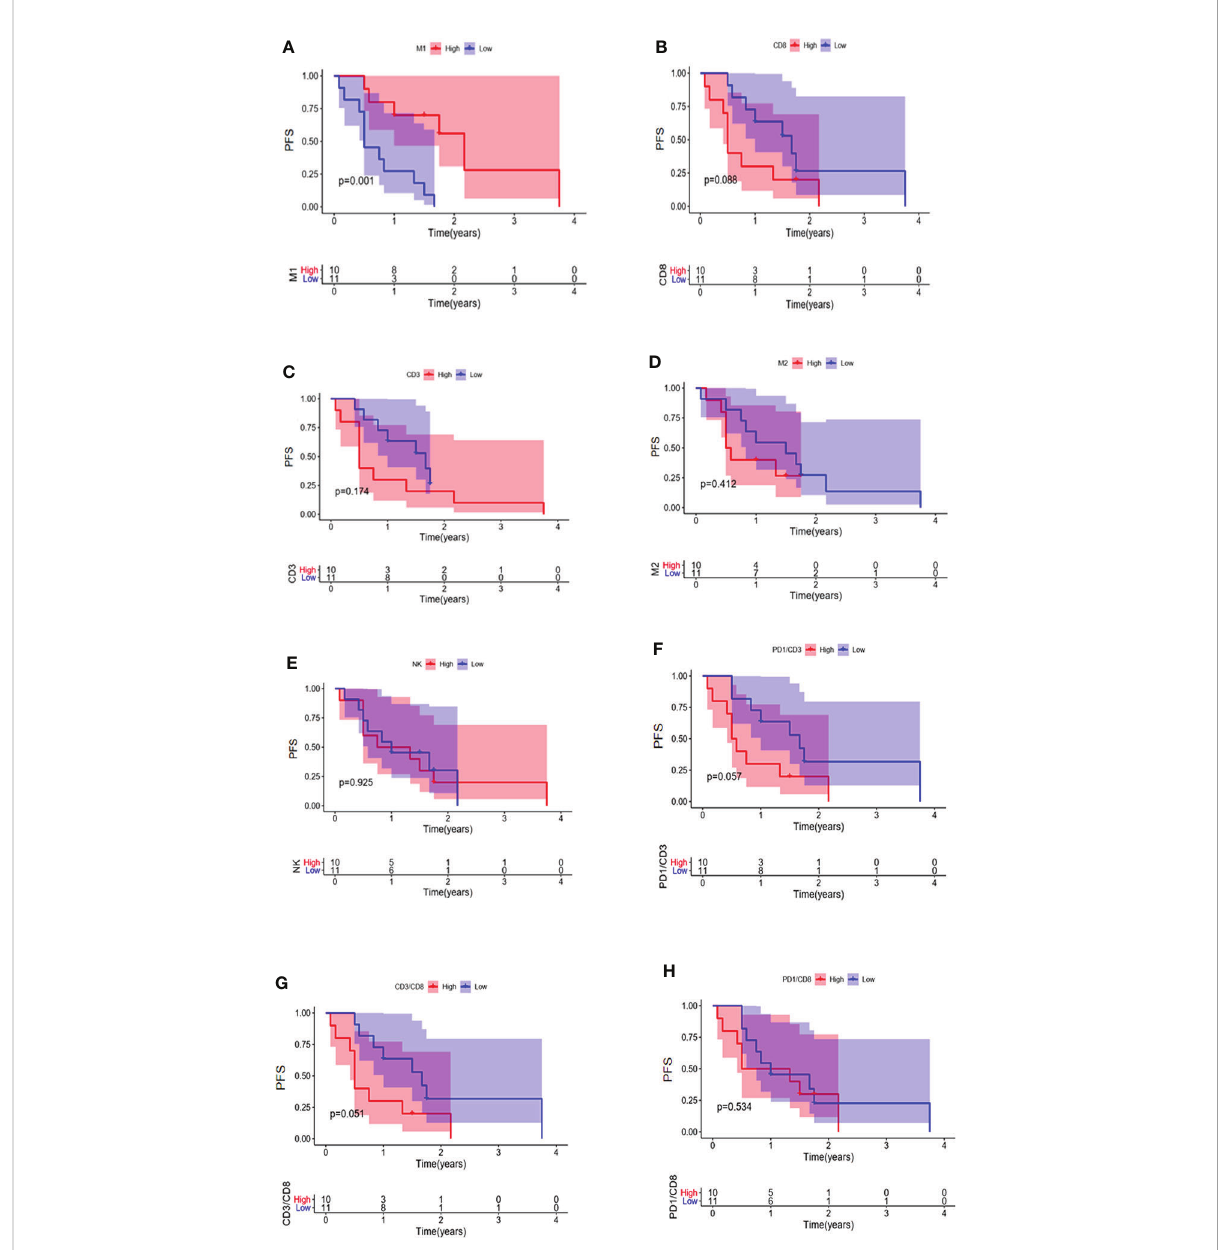
FIGURE 7 PFS in EGFR-mutated NSCLC patients with different in fi ltrations of immune cells. Comparison of patient PFS between high and low in fi ltration of M1 macrophages (A) , CD8 + T cells (B) , CD3 + T cells (C) , M2 macrophages (D) , NK cells (E) , CD3 + PD1 + T cells (F) , CD3 + CD8 + T cells (G) , and CD8 + PD1 + T cells (H)